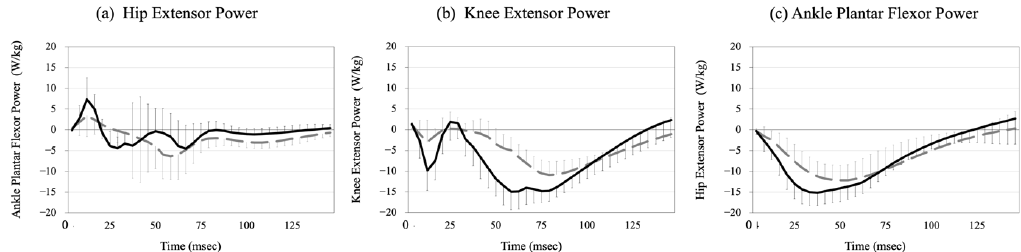
Figure 3. Power curves over time, in lower extremity joints of the valgus and varus groups during DVJ landings. Means of the hip extensor ( a ), knee extensor ( b ), and ankle plantar flexor ( c ) powers, and standard deviations of the valgus (solid lines) and knee varus groups (broken lines) during landings of